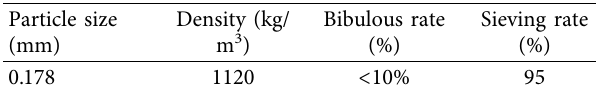
Table 3: Properties of the rubber